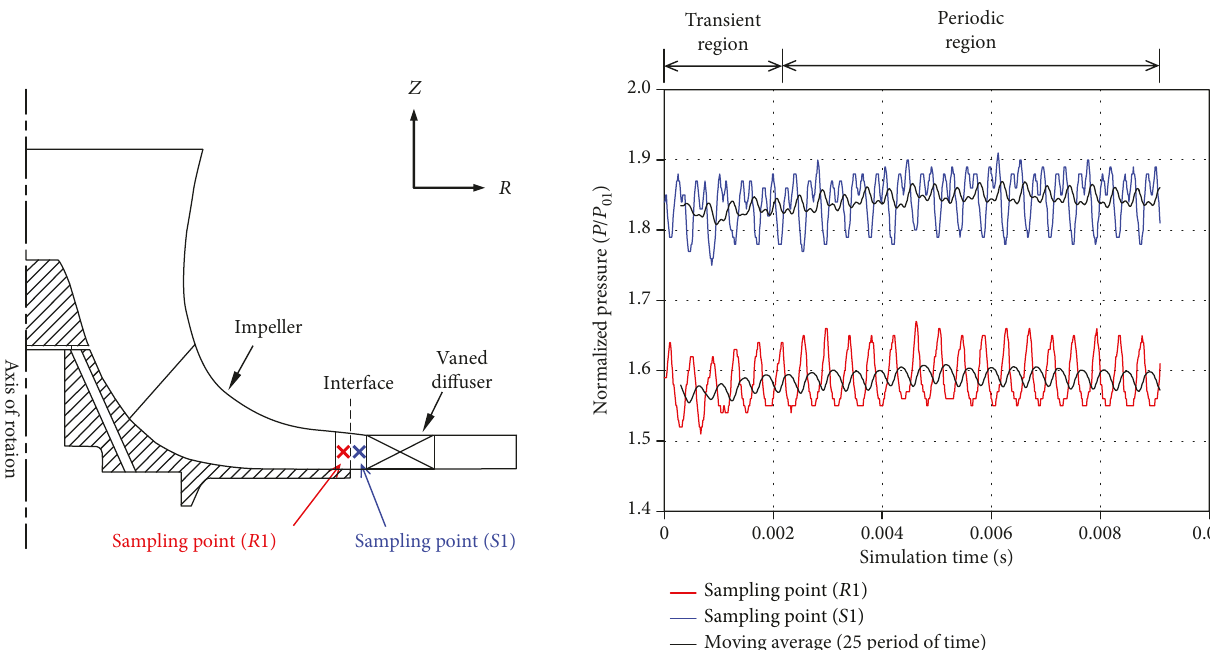
Figure 4: Static pressure at the impeller exit and vaned di ff user inlet during the